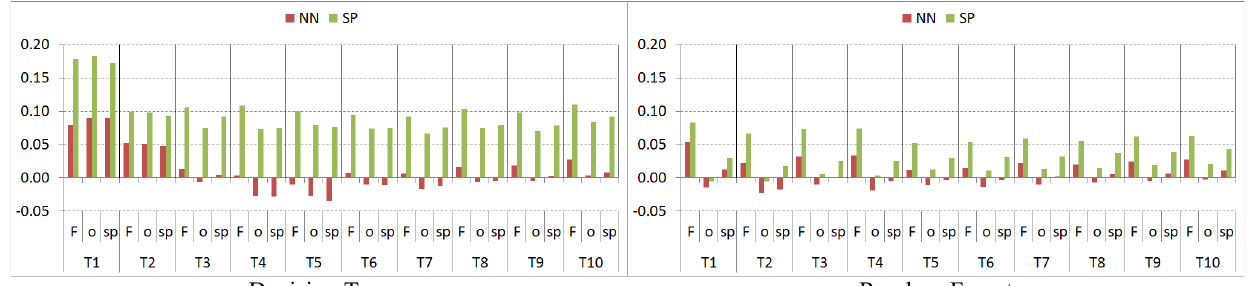
Figure 15. The plots of classification accuracy differences of final self-training results comparing NN and SP to T for the two base learners. The selection methods are i i i abbreviated as F ( full ), o (NH ), and sp (NH o sp